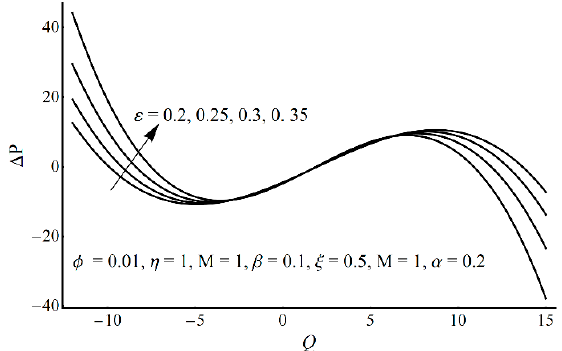
Figure 9. Pressure gradient at various values of variable η . Coatings 2020 , 10 , x FOR PEER REVIEW